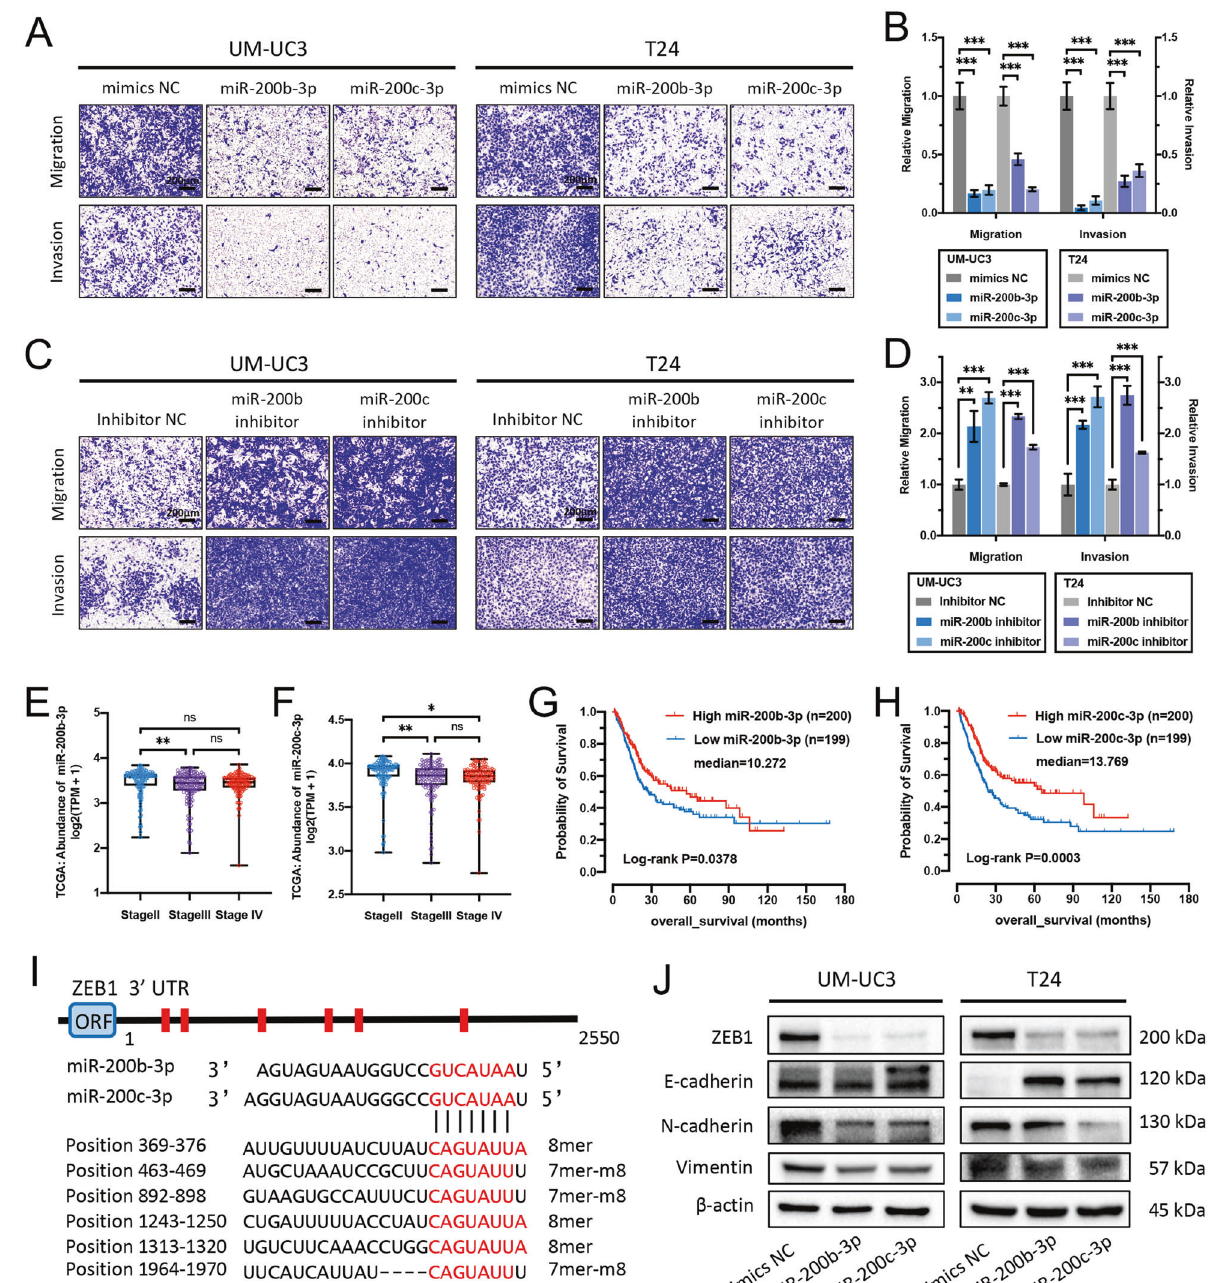
Fig. 4 miR-200b-3p and miR-200c-3p suppress BCa cell invasion and metastasis via targeting ZEB1. A – D Effects of miR-200b-3p/miR-200c- 3p mimics ( A, B ) and miR-200b-3p/miR-200c-3p inhibitors ( C, D ) on cell migration and invasion capabilities were assessed through transwell migration and Matrigel invasion assays in UM-UC3 and T24 cells, respectively. Scale bar = 200 μ m. E, F MiR-200b-3p and miR-200c-3p expression levels in different pathologic-stage BCa from the TCGA database. G, H Kaplan – Meier survival analysis indicated better survival probability in BCa patients with higher miR-200b-3p ( G ) or miR-200c-3p ( H ) expression levels (TCGA database). I Schematic graph of human ZEB1 3 ′ UTR and conserved miR-200bc-3p-site sequences. ORF: open-reading frame. J Western blotting assays indicated that miR-200b-3p/ miR-200c-3p can downregulate the expressions of ZEB1, N-Cadherin, and vimentin, while upregulating E-Cadherin in BCa cells. Data are expressed as the means ± SD for n = 3. ns, no signi fi cance; * P < 0.05; ** P < 0.01; *** P < 0.001. from protein-encoding exons and predominantly locate in the factor for BCa progression and could be applied as a novel cytoplasm [32]. Since circKDM4C is derived from three exons of the potential biomarker or therapeutic target for BCa management. KDM4C gene and mainly localized in the cytoplasm, we performed The “ miRNA sponge ” model, also referred to as competing circRNA RNA pull-down and dual-luciferase reporter assays. MiR- endogenous RNA (ceRNA), is one of the most classical mechanisms 200b-3p and miR-200c-3p were found to be pulled down with direct for ncRNAs, including circRNAs [12, 13]. Previous studies demon- interactions by circKDM4C. Furthermore, following functional assays strated that circRNAs functioned as miRNA sponges should derive Cell Death Discovery (2021)